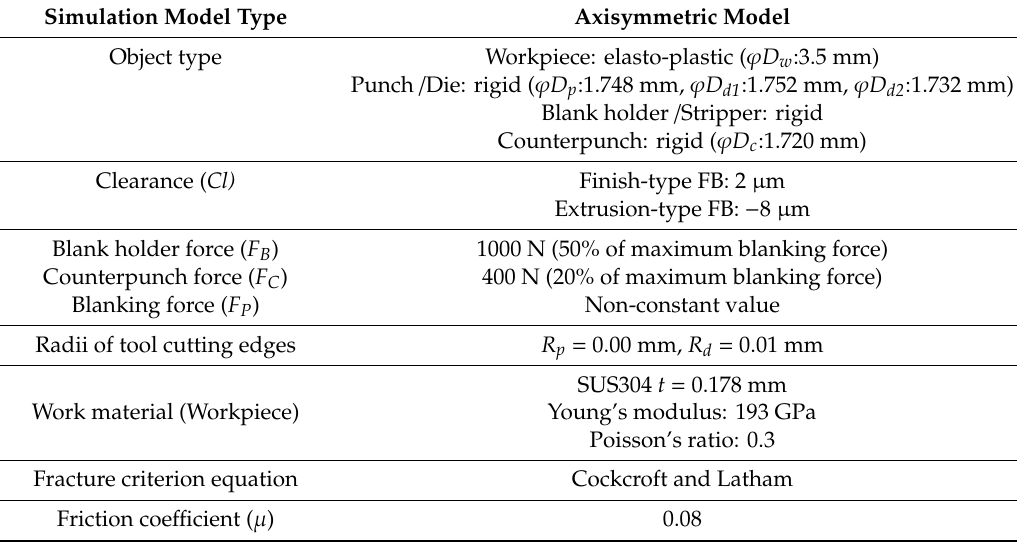
Figure 3. Flow stress-plastic strain curve. Table 1. FEM simulation conditions.